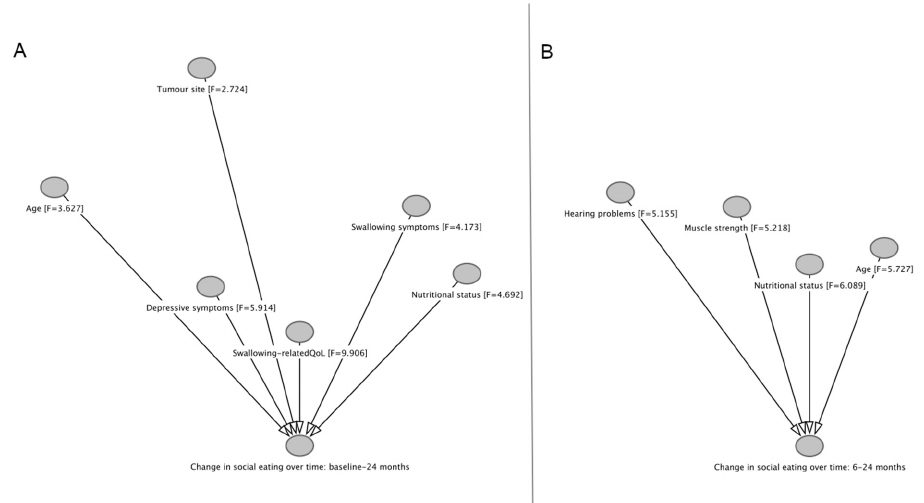
Figure 5. Patients’ features with hypothesized causal relationships with changes in social eating problems from baseline to 24 months ( A ) and from 6 to 24 months follow-up ( B ). Shorter arrows indicate stronger associations.